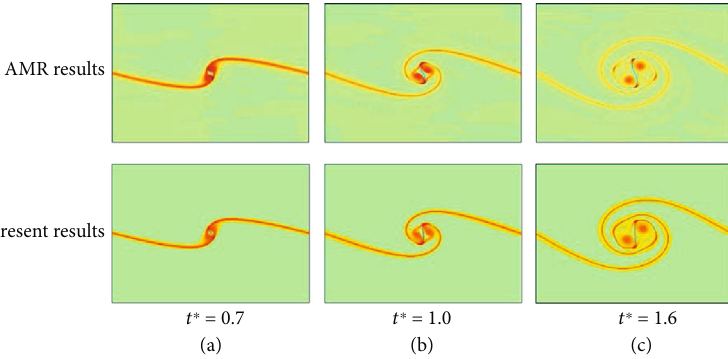
Figure 3: Vorticity contours (color) and interface locations (red line) of AMR scheme [12] and present model with Re = 10000 , We = 400 , ρ = ρ , and ν = ν . A B A B